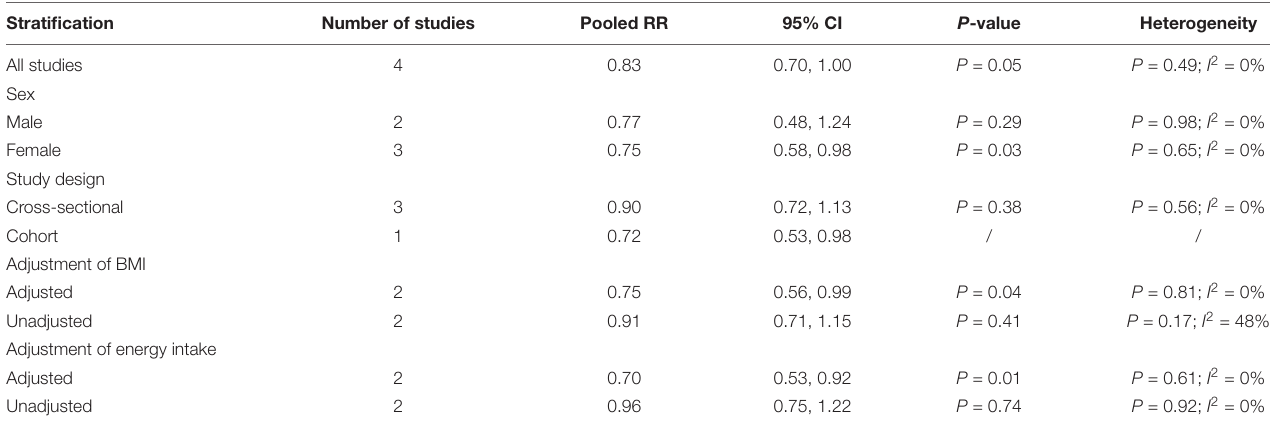
FIGURE 2 | Forest plot of meta-analysis: Overall multi-variable adjusted RR of depression for the highest vs. lowest category of dietary vitamin A intake. TABLE 2 | Subgroup analysis of depression for the highest vs. lowest category of dietary vitamin A